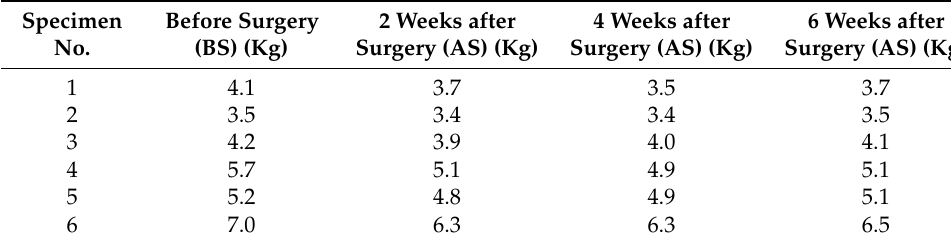
Table 4. Weight distribution of the cases, before and after surgery, in group one.